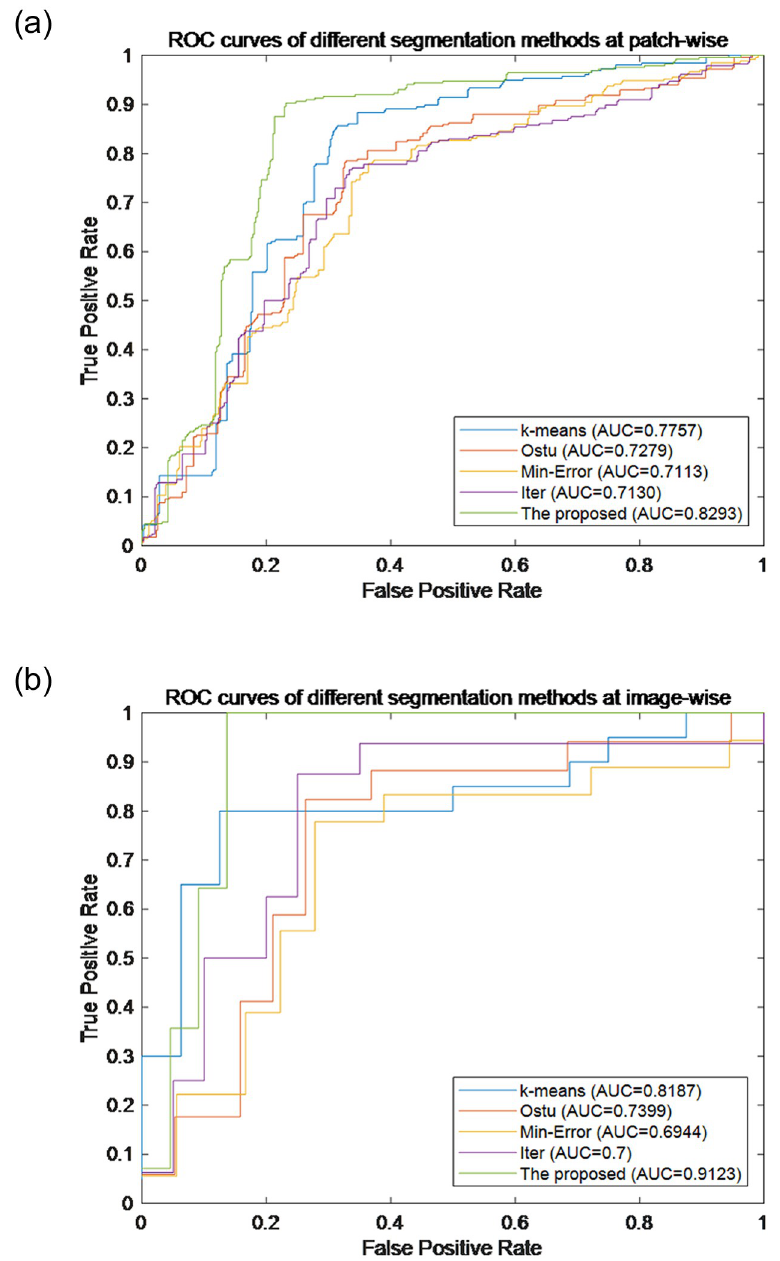
Fig 10. ROC curves of different segmentation methods. (a) ROC curves of different segmentation methods at patch- wise, (b) ROC curves of different segmentation methods at image-wise.